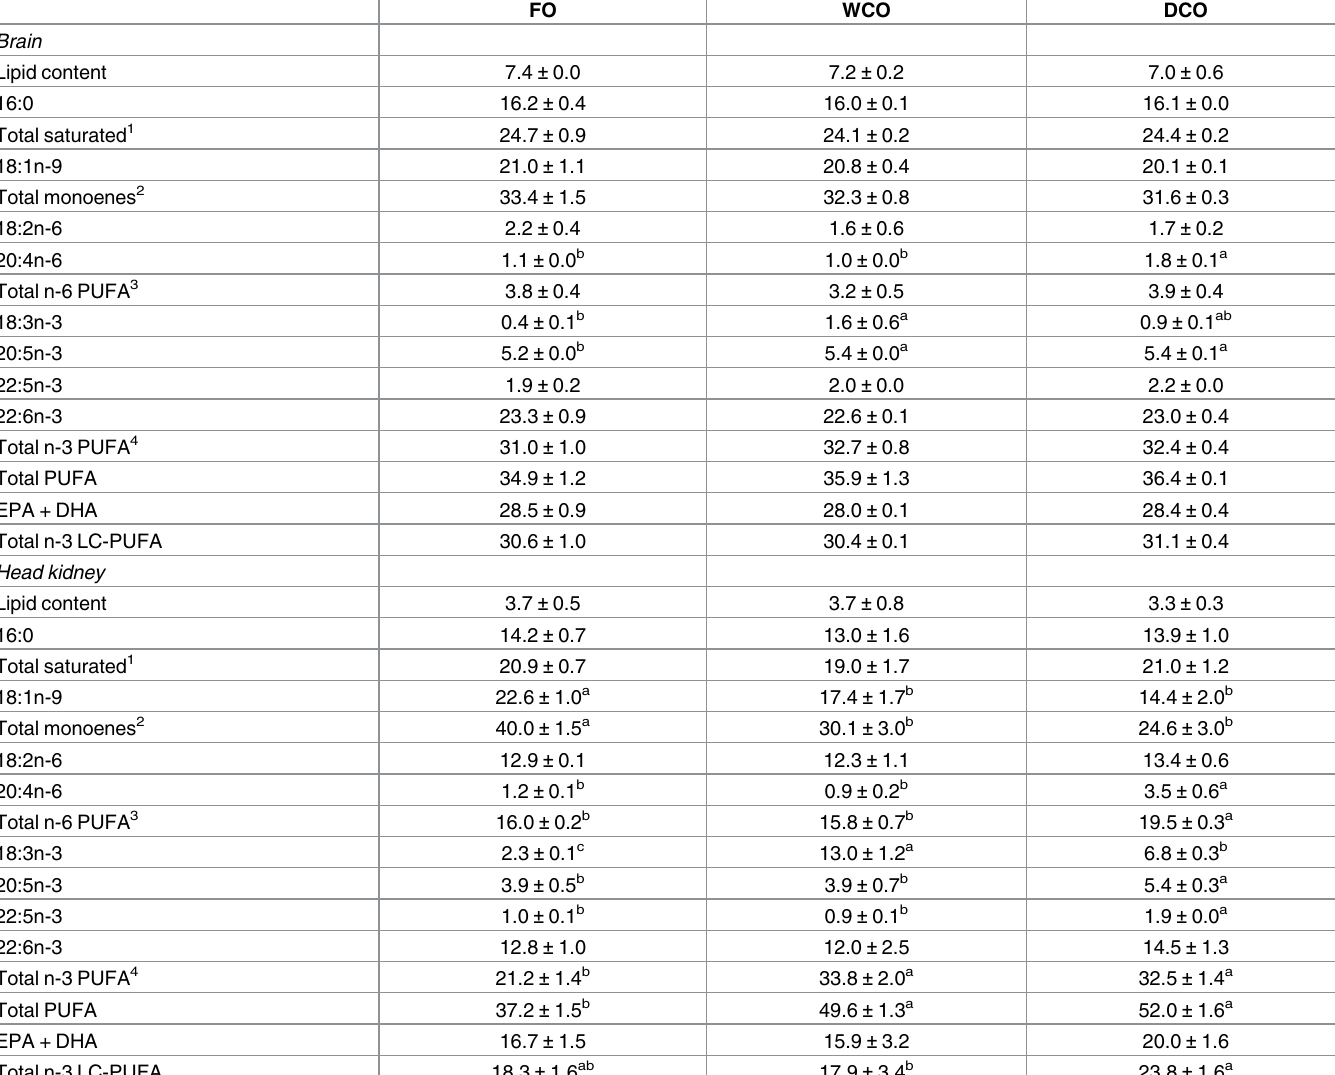
Table 4. Lipid contents (percentage of wet weight) and fatty acid compositions (percentage of total fatty acids) of total lipid of the brain and head kidney (n = 3) after feeding the experimental diets for 12 weeks.